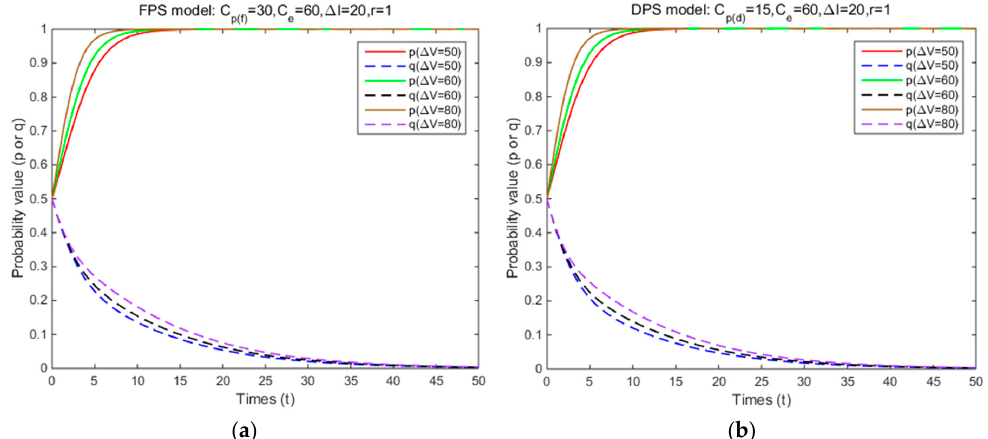
Figure A3. The effects of perceived relative benefit on strategy probabilities of cyclists and law enforcement under FPS ( a ) and DPS ( b ) (Situation 1).